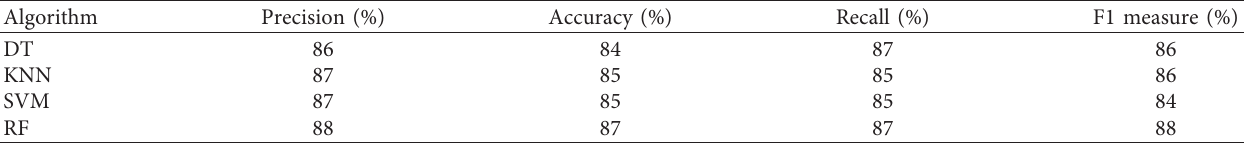
Table 4: The detailed results of the